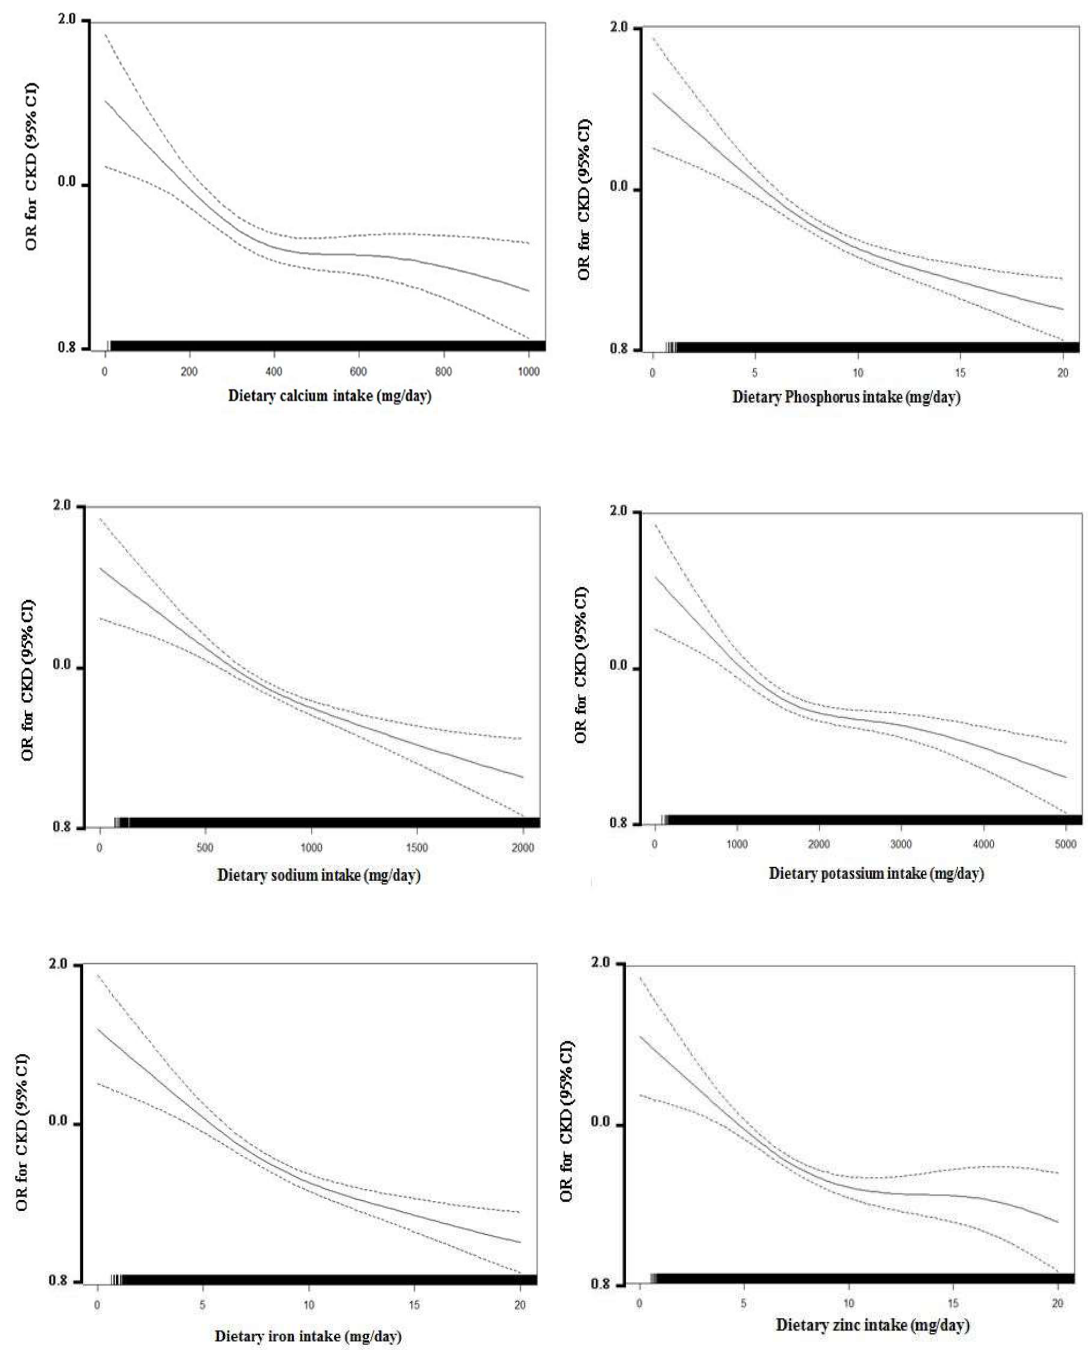
Figure 2. Multivariate association of continuously measured dietary mineral intake levels (mg/day) and chronic kidney disease